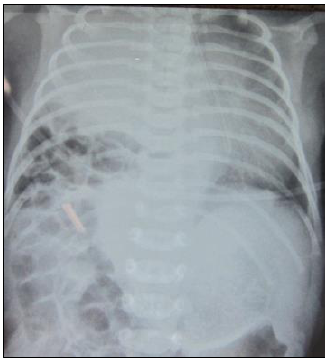
Figure 2: Showing